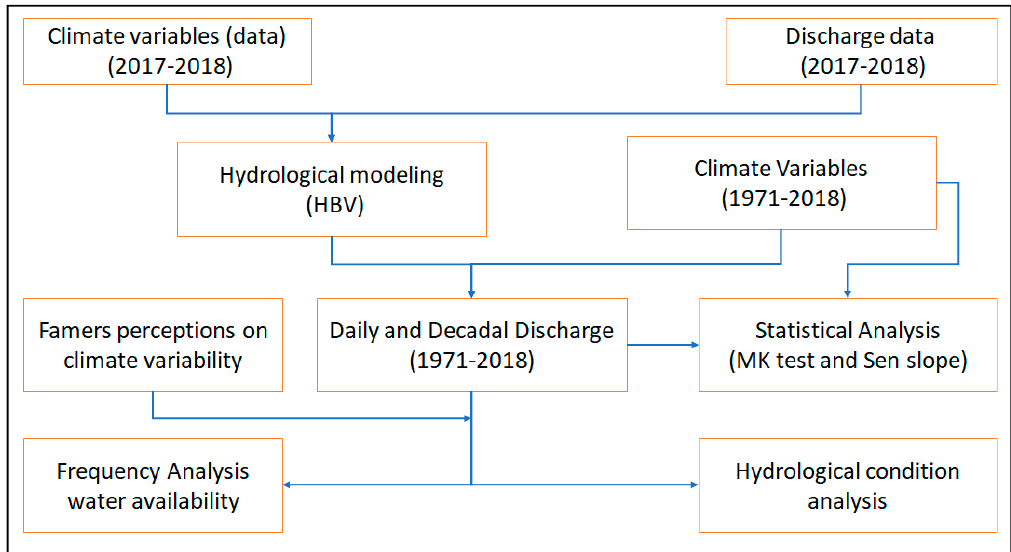
Figure 4. Methodological framework of the study.